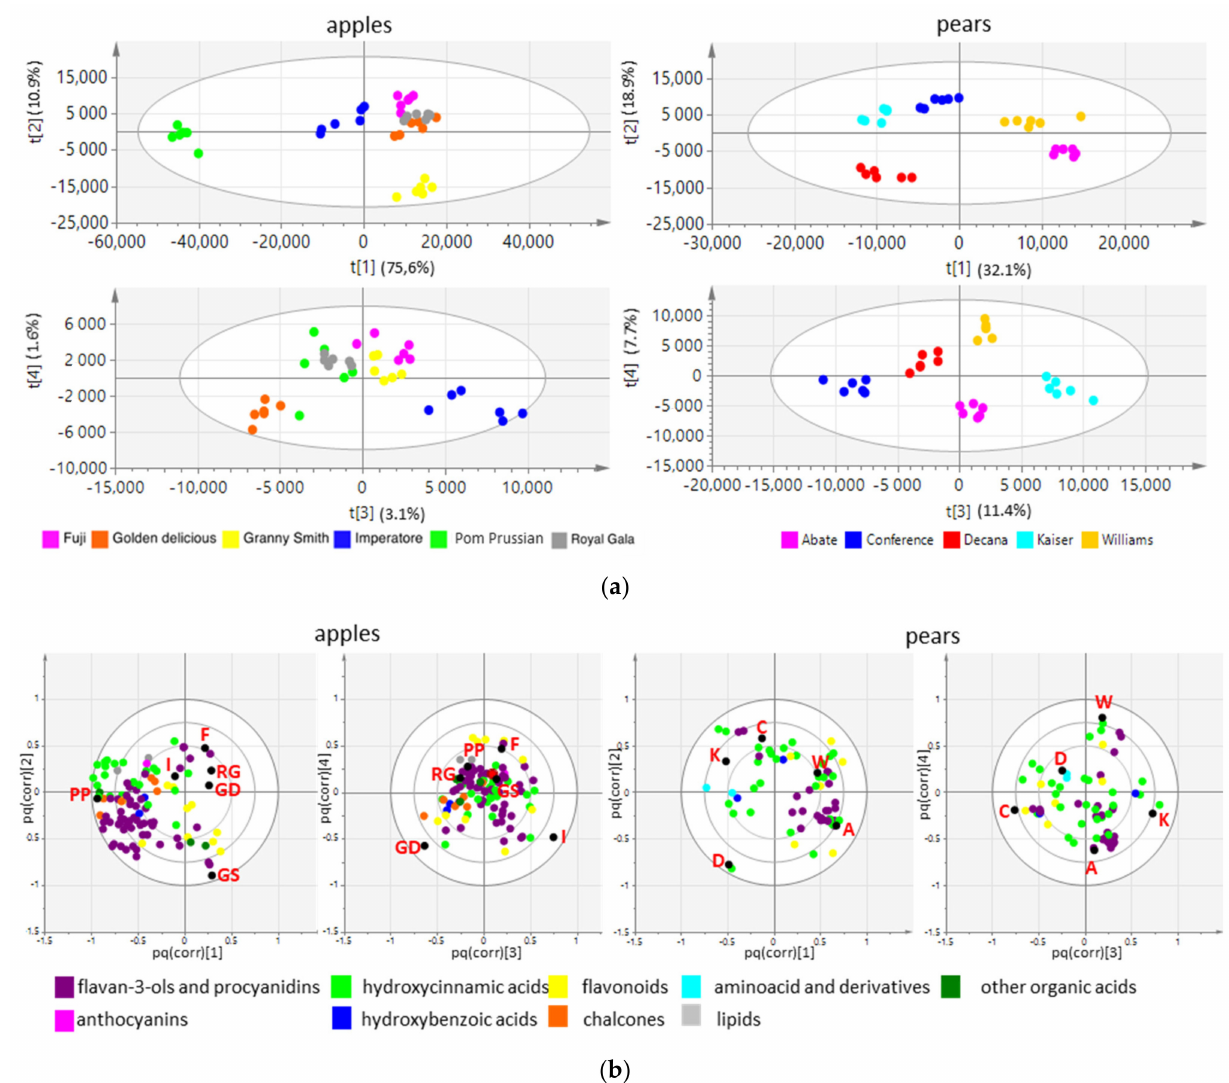
Figure 5. Supervised O2PLS-DA of apples and pears based on HPLC-ESI-MS data matrices. ( a ) Apple ( left ) and pear ( right ) score plots, with color dots representing different cultivars as defined in the key. ( b ) Apple ( left ) and pear ( right ) loading plots, with color dots representing different metabolite classes as defined in the key. Abbreviations for cultivars: Fuji (F), Golden Delicious (GD), Granny Smith (GS), Imperatore (I), Pom Prussian (PP), Royal Gala (RG); Abate (A), Conference(C), Decana del Comizio (D), Kaiser (K), and Williams